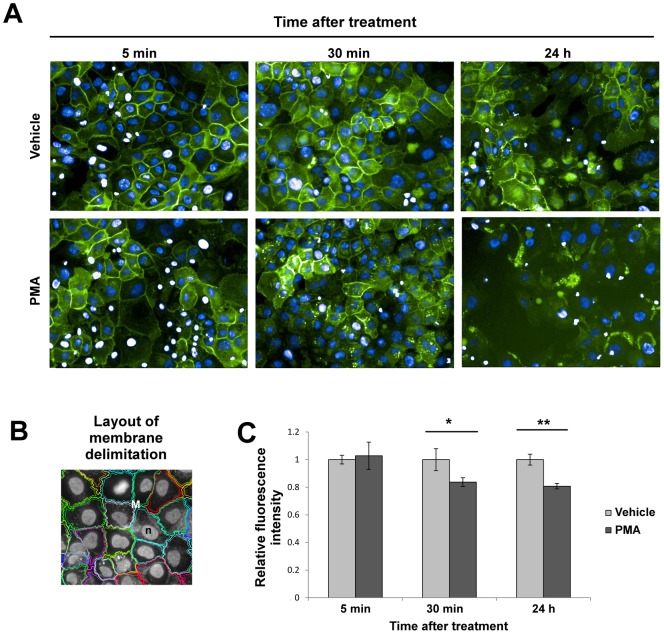
Loss of membrane-bound syndecan-1 localization after PMA treatment in SCC-9 cells.SCC-9 cells were treated with PMA for 5 min, 30 min and 24 h, fixed, and labeled for syndecan-1 with goat anti-syndecan-1 antibody. (A) Immunofluorescence images revealed diminished syndecan-1 in membrane localization after 30 min and 24 h of PMA treatment. Green: anti-goat antibody conjugated with Alexa Fluor 488. Blue: DAPI. (B) Example of masks used for quantification of syndecan-1 in the cell surface membrane. (C) Quantification performed by the Operetta high content image system showed loss of cell membrane of syndecan-1 after 30 min and 24 h of PMA treatment. Three independent experiments were performed. Columns represent mean ± SD (n = 3) and * and ** indicate p<0.05 and p<0.01, respectively.